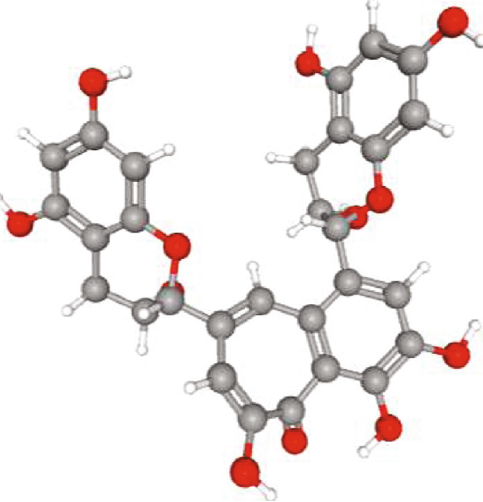
Figure 7: Molecular structure of thea fl